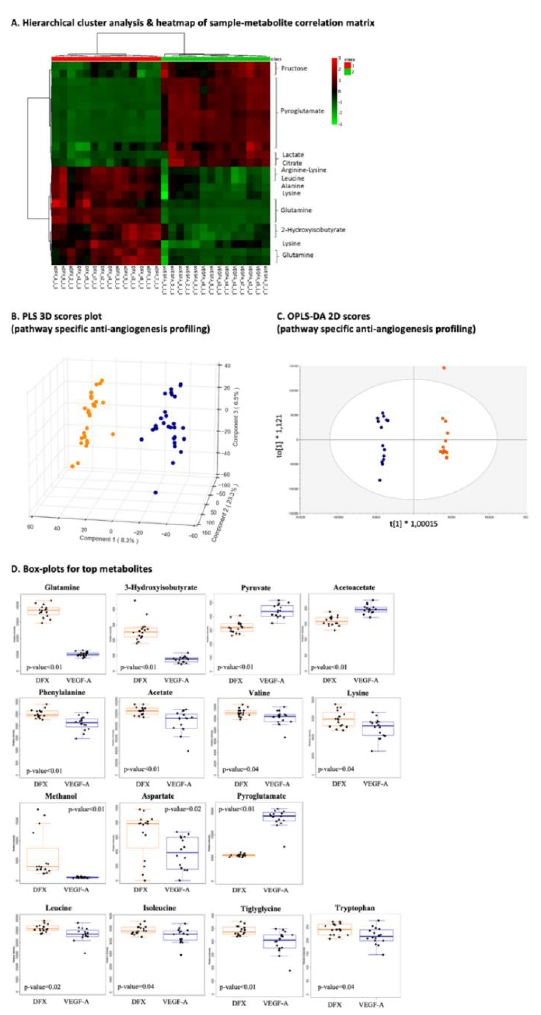
Figure 4. Pathway-specific anti-angiogenesis profiling. ( A ) Hierarchical cluster analysis and heatmap of sample–metabolite correlation matrix. Each square indicates the Pearson’s correlation coefficient of a pair of samples and metabolite(s) based on the analysis of variance values (group comparison-d; amifostine_sunitinib_deferoxamine, n = 28 vs. amifostine_sunitinib_ VEGF-A, n = 28). VEGF-A amifostine_1 cell extract is depicted and considered as an outlier as well as in the multivariate PCA models due to high glycerol concentration (the amount of glycerol distorts an NMR spectrum by affecting proton signal, resulting in a skewed NMR profile); ( B ) PLS 3D scores plot with R2 greater than 0.8 and Q2 equal to 0.8 using three components; ( C ) OPLS-DA 2D scores plot; ( D ) boxplots of top metabolites and their p -values (group comparisons are color-coded; orange, angiogenesis stimulation and blue, angiogenesis